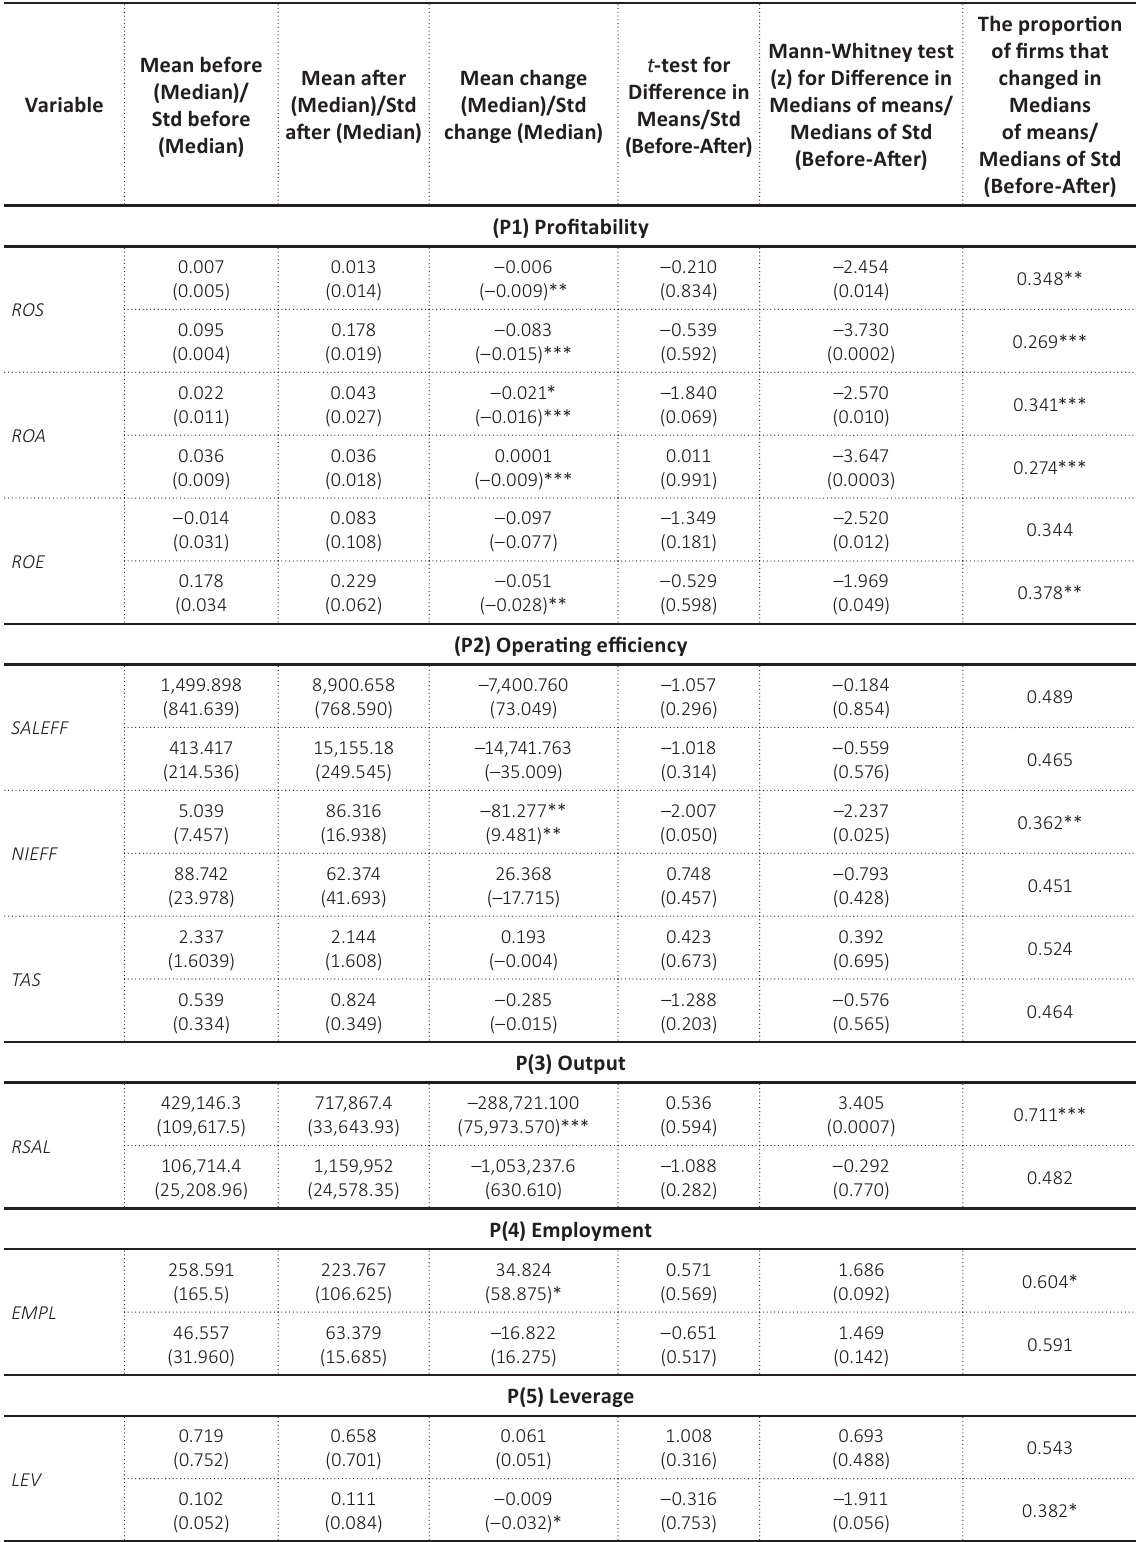
Table A3. Performance changes of privatized SOEs in the services sector (privatized SOEs with tax